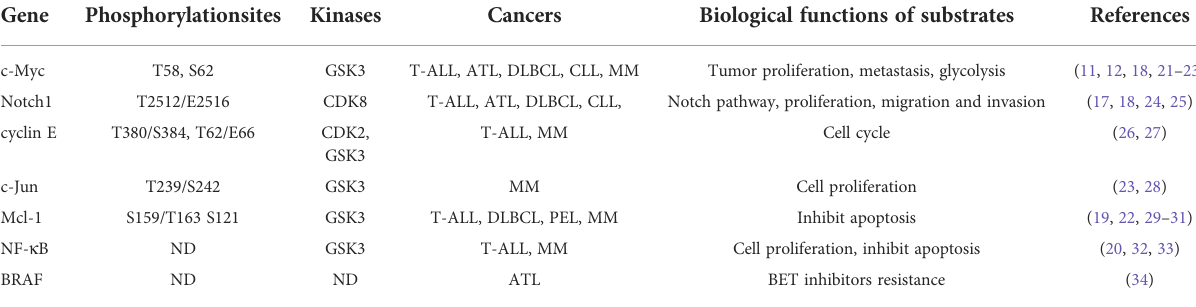
TABLE 1 FBW7 substrates and major biological functions in lymphoproliferative